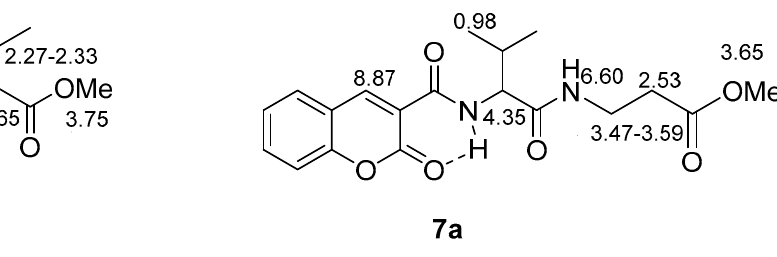
Figure 2. Selected 1 H NMR δ values of compounds 4e and 7a .